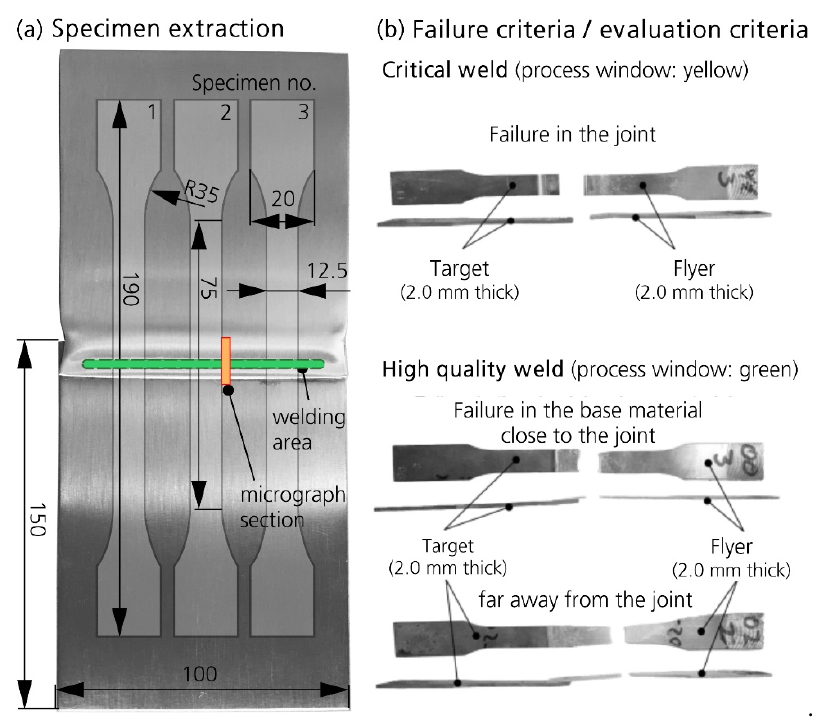
Figure 3. ( a ) Specimen extraction from welded samples; ( b ) Different failure modes of the lap shear specimens. shear